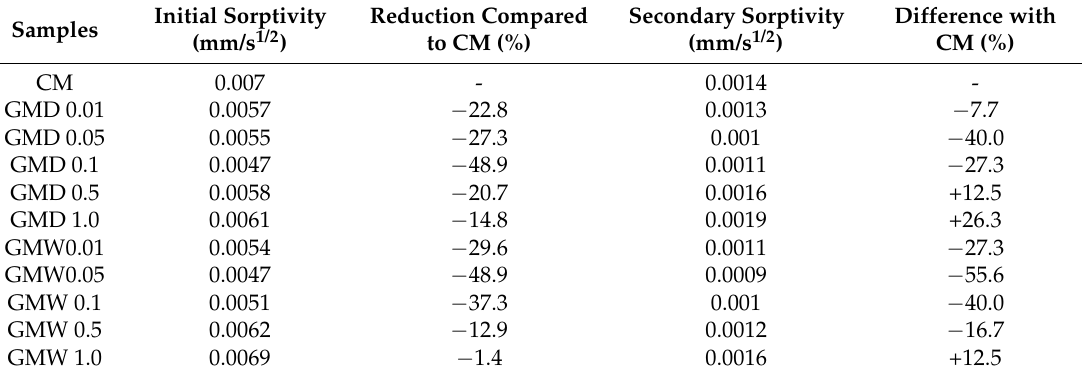
Figure 14. Water sorptivity of EOGO-mortars: ( a ) Dry-mix design and ( b ) wet-mix design. Table 5. Initial and secondary sorptivity of mortar mixes for the dry and wet-mix designs *.